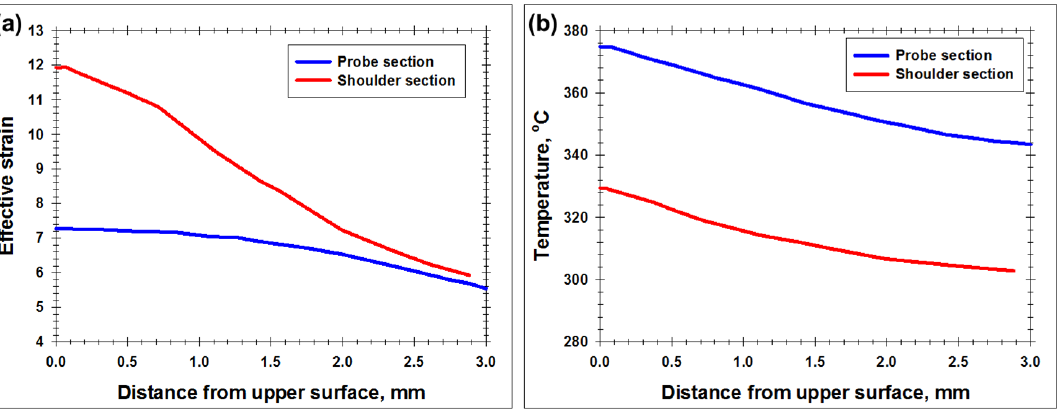
Figure 5. Typical through-thickness distributions of accumulated effective strain ( a ) and temperature ( b ) calculated at the weld centerline for the weld sections directly behind the tool probe and that behind the shoulder edge. Note: The distributions for the 500–380 weld is shown.